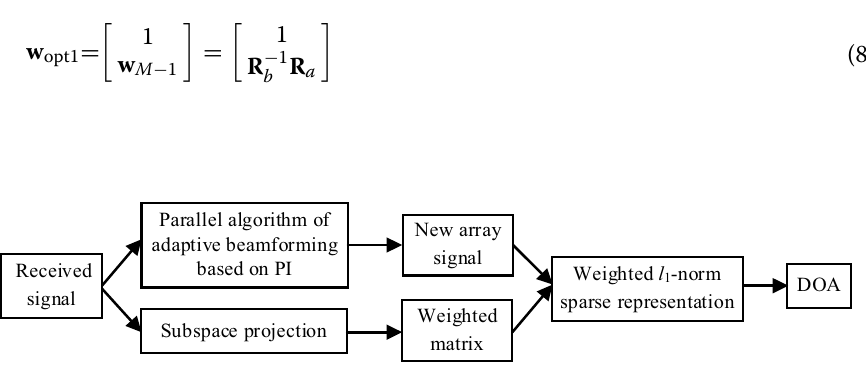
Fig. 1 Flow chart of the proposed